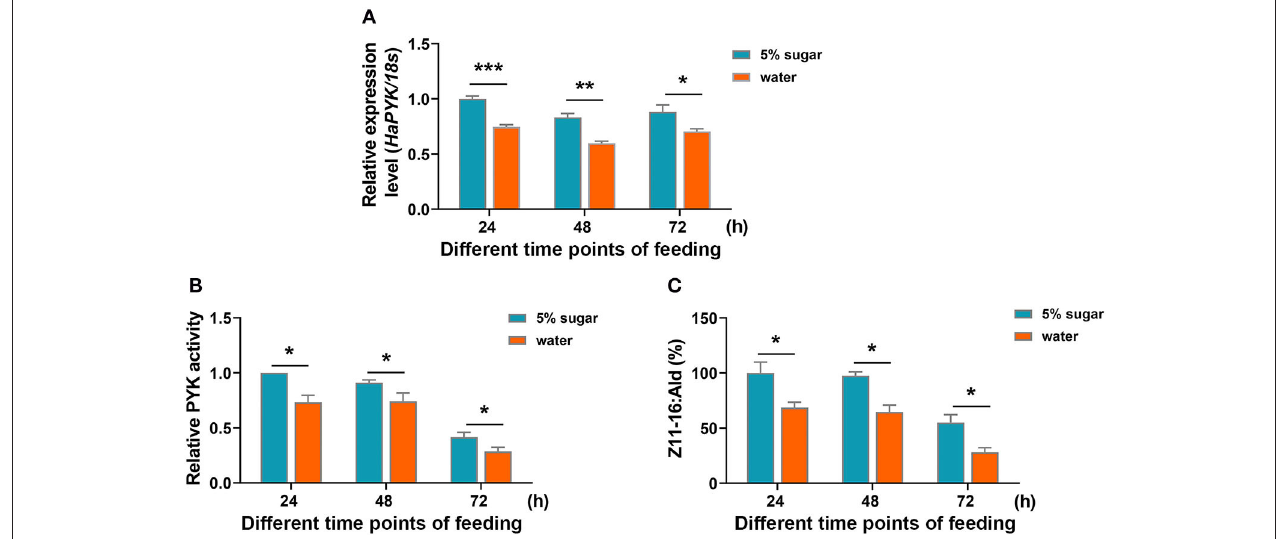
FIGURE 5 | Sugar feeding increased HaPYK activity and subsequent Z11-16:Ald production. (A) The expression analysis of HaPYK in PGs under sugar/water feeding for different time points (24, 48, and 72h) by qRT-PCR. The 18S was used as the internal reference. Error bars indicated the mean ± s.d. of three independent biological experiments and three technical repetitions. * P < 0.05, ** P < 0.01, *** P < 0.001(Student’s t -test). (B) The effect of sugar feeding on HaPYK activity. Error bars indicated the mean ± s.d. of three independent biological experiments and three technical repetitions. * P < 0.05 (Student’s t -test). (C) The effect of sugar feeding on Z11-16:Ald production in PGs. Error bars indicated the mean ± s.d. of three independent biological experiments and three technical repetitions. * P < 0.05 (Student’s t